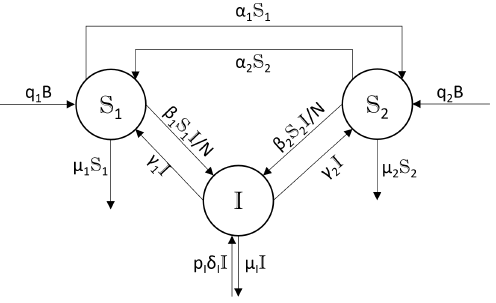
Figure 4. Flow diagram of the master model. B = δ 1 S 1 + δ 2 S 2 + ( 1 − p I ) δ I I denotes the number of newborns who are not infected per unit of